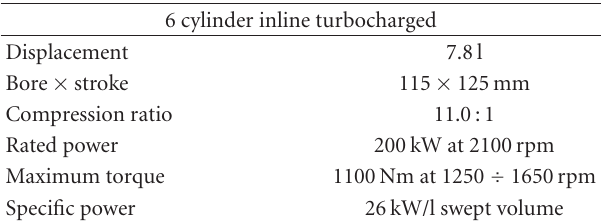
Table 4: Main characteristics of IVECO CURSOR 8 CNG EURO V